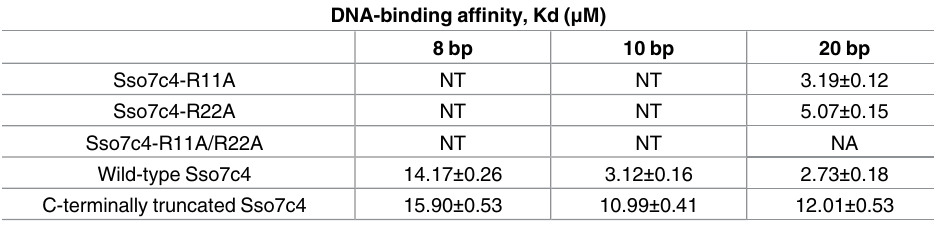
Table 1. Binding affinities for the arginine mutant/wild-type/C-terminally truncated/proteins in com- plex with three dsDNA fragments of different